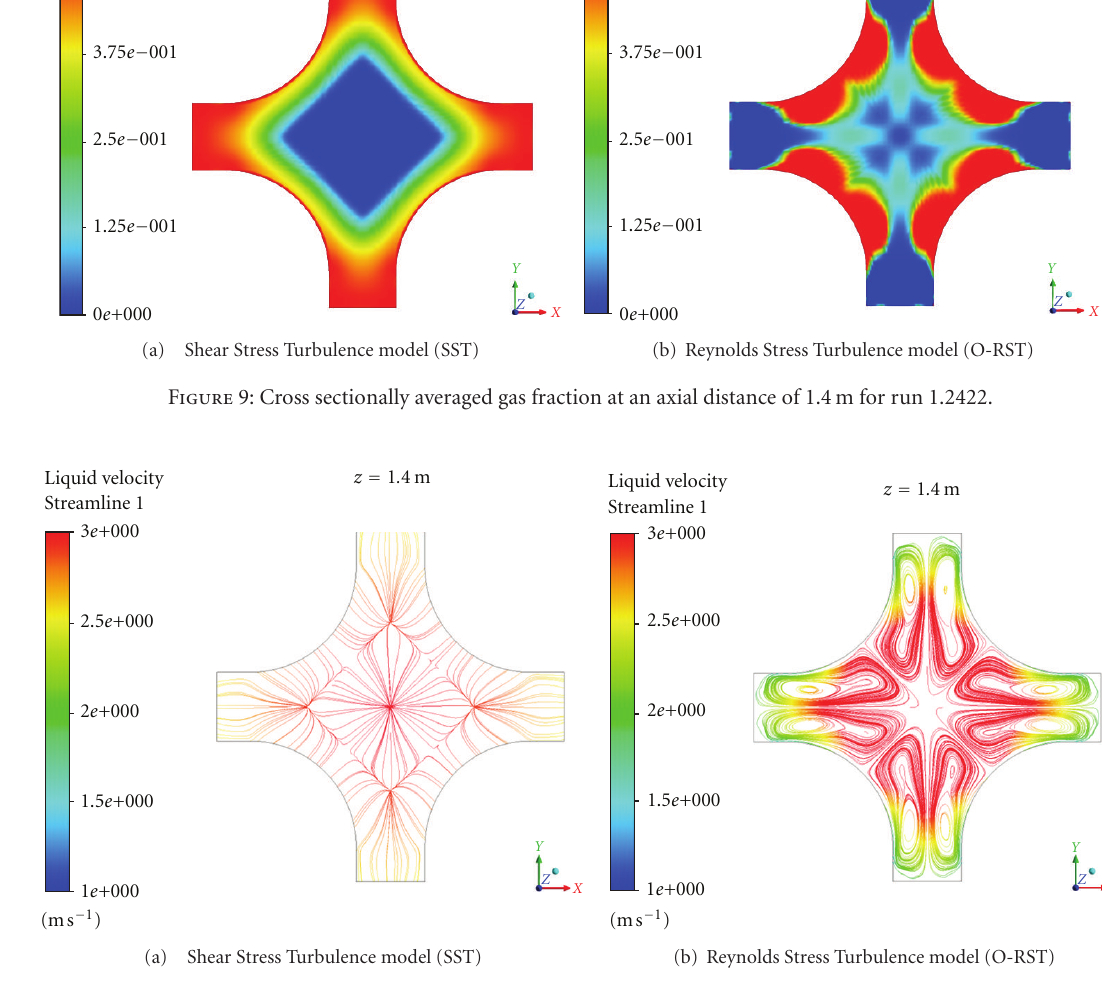
Figure 10: Velocity stream lines projected in a plane at an axial height of 1.4 m for run